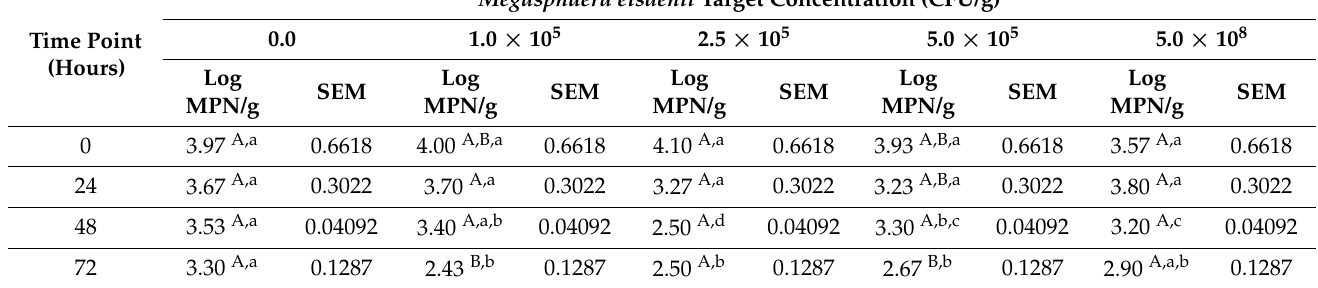
Table 4. Mean concentration (log 10 MPN/g) of Salmonella that is resistant to one or more antibiotics in inoculated cattle feces at 0, 24, 48, and 72 h following treatment with varying concentrations of Megasphaera elsdenii as an in vitro model.